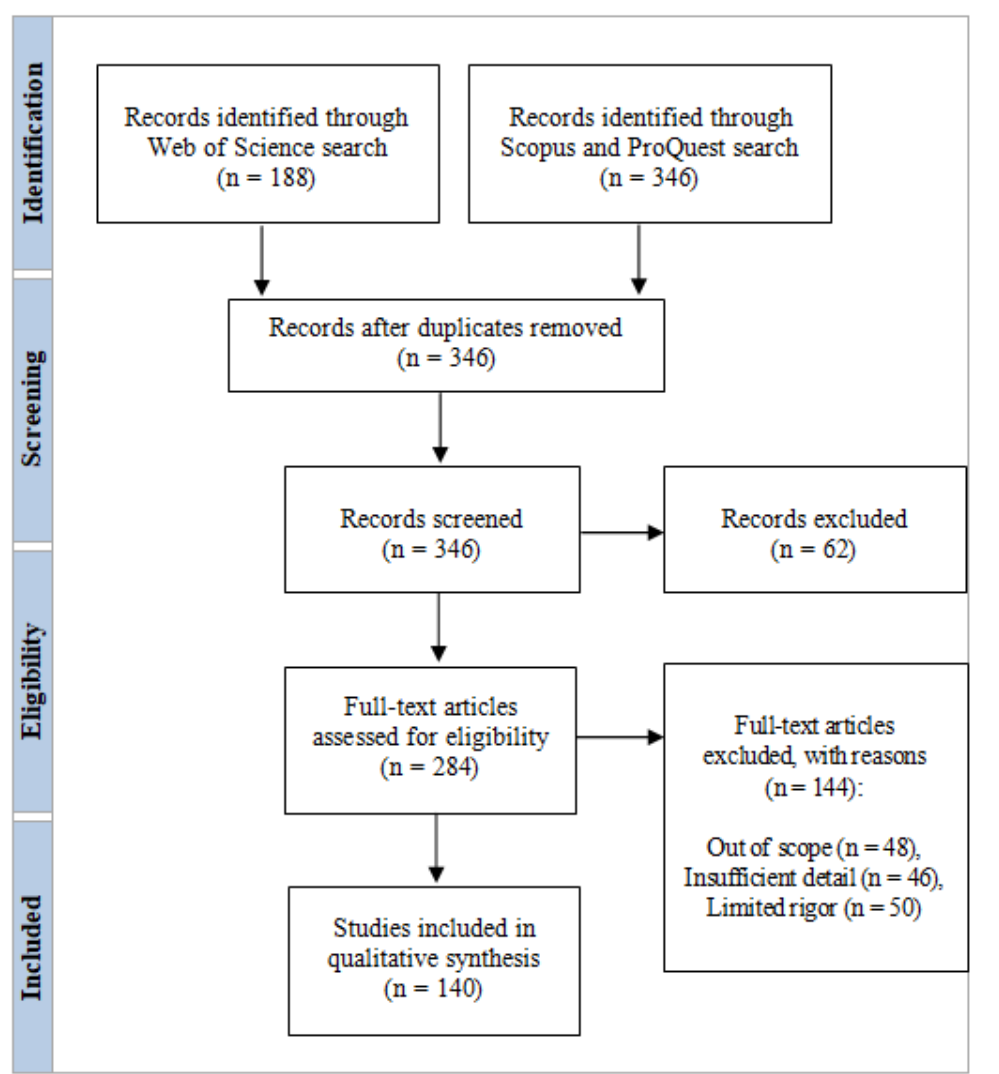
Figure 1. PRISMA flow diagram describing the search results and screening. Table 1. Topics and types of paper identified and